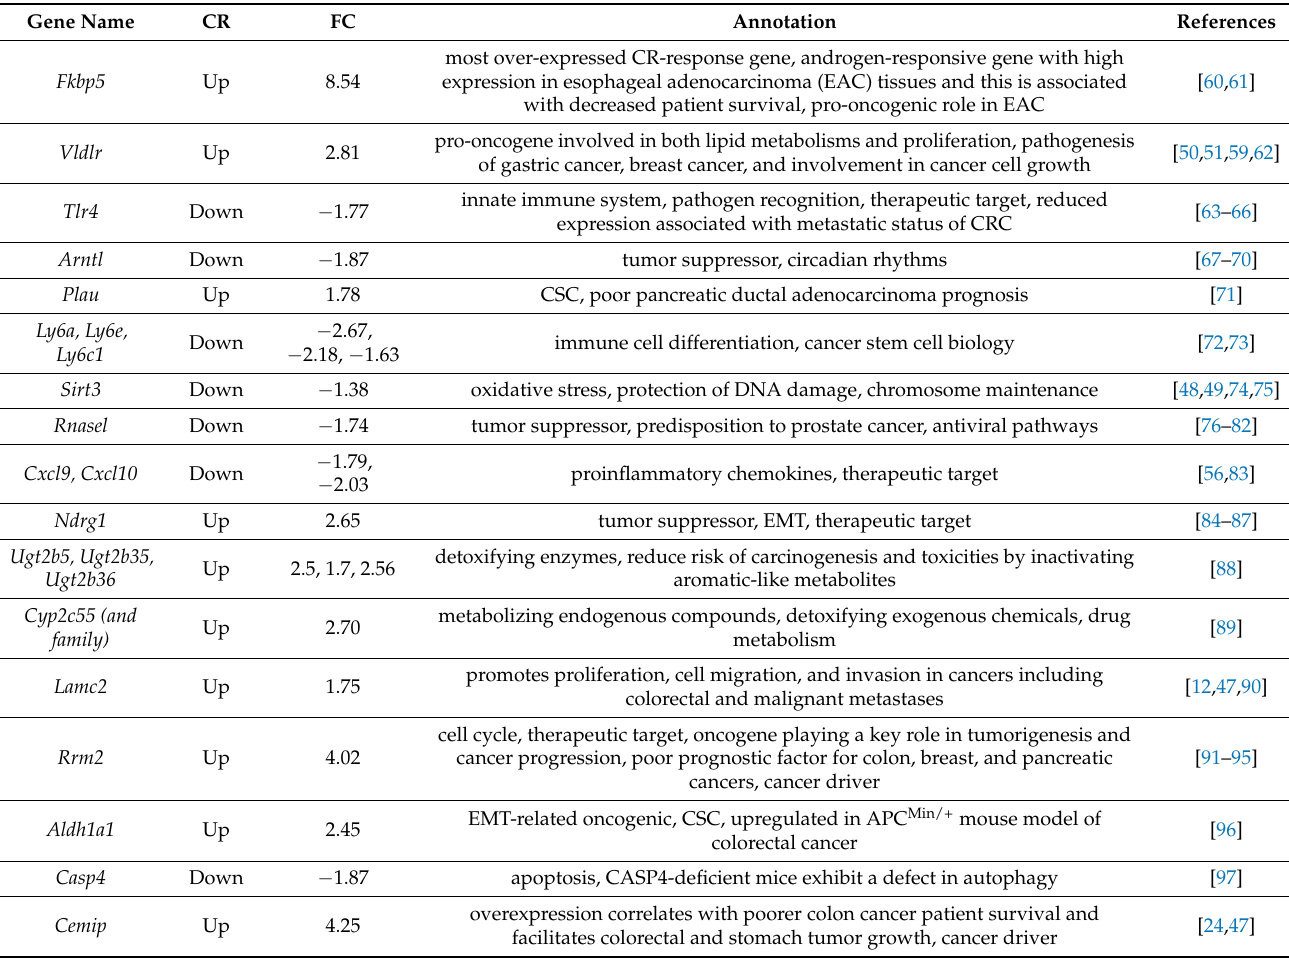
Table 1. CR DEGs in tumor suppressive, oncogenic, immune, epithelial stem/progenitor, anti-cancer, and detoxifying